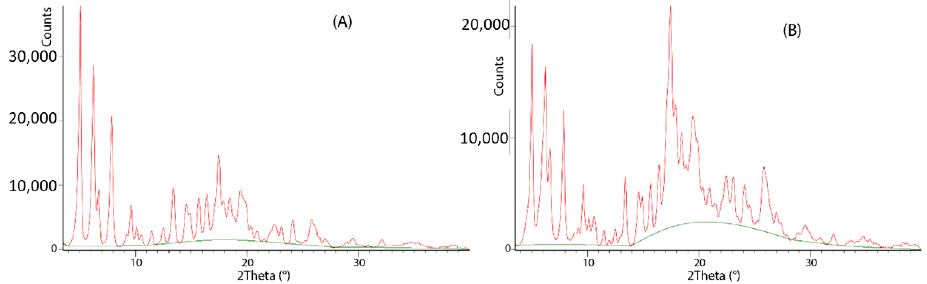
Figure 6. XRD profiles of the xerogel XG02 ( A ) and the xerogel XG1 . ( B ) The red and green lines show the diffraction pattern and the amorphous band, respectively.